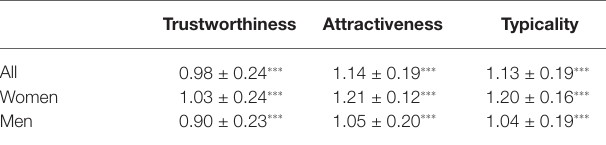
TABLE 2 | Descriptive statistics on agreements (Z-value) in trait judgments ( M ± SD ).